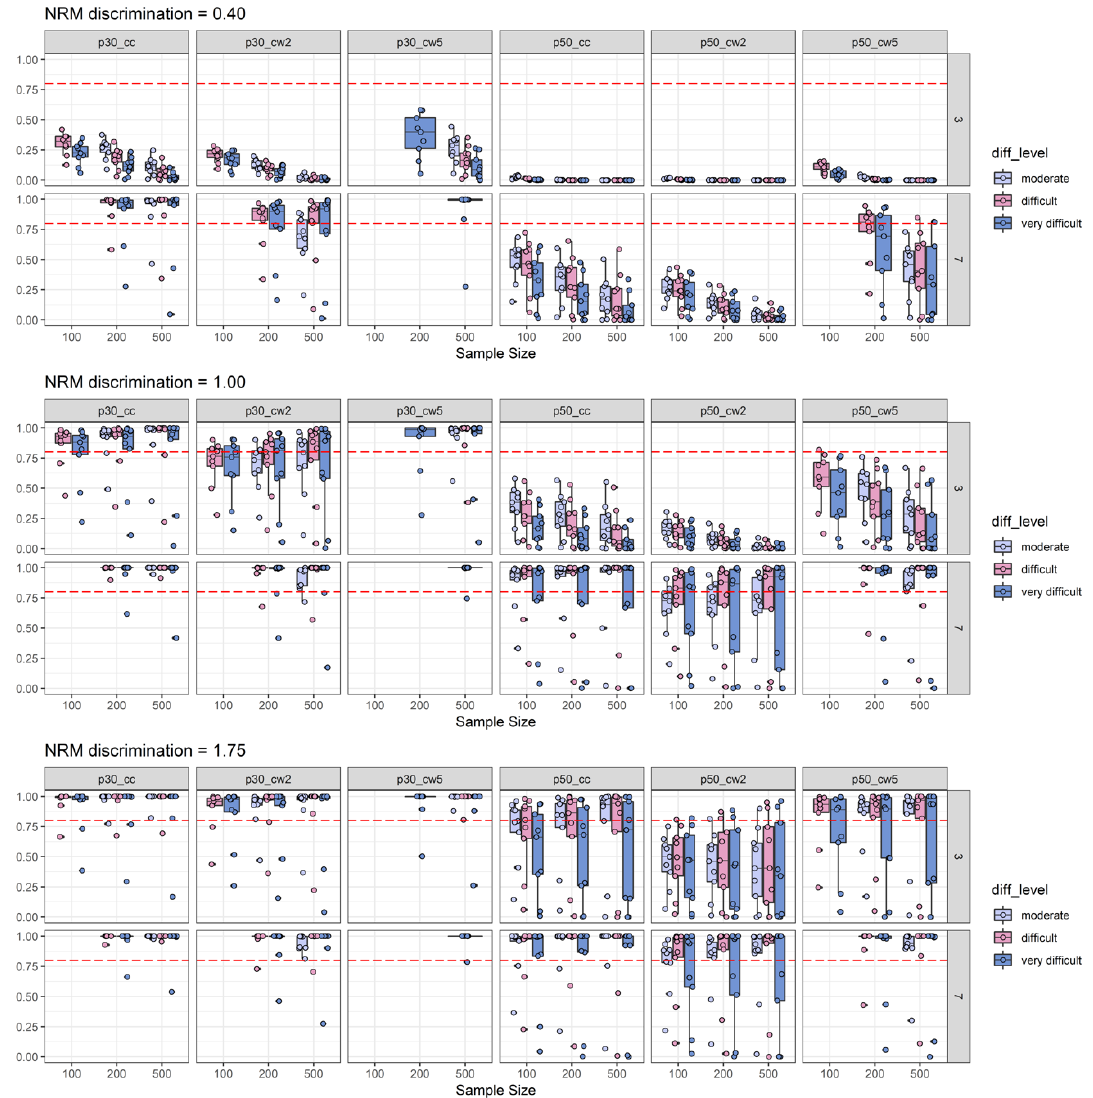
Figure 4. 2PL-difficulty split of empirical power analysis: Depiction of the empirical power (y-axis) as a function of NRM discrimination, sample size (x-axis), number of distractors, 2PL-difficulty (diff_level: Moderate vs. difficult vs. very difficult), and effect size measures combined with effect size thresholds. The horizontal red dashed line represents the target power level of 0.80. For more explanations, see Figures 2 and 3.